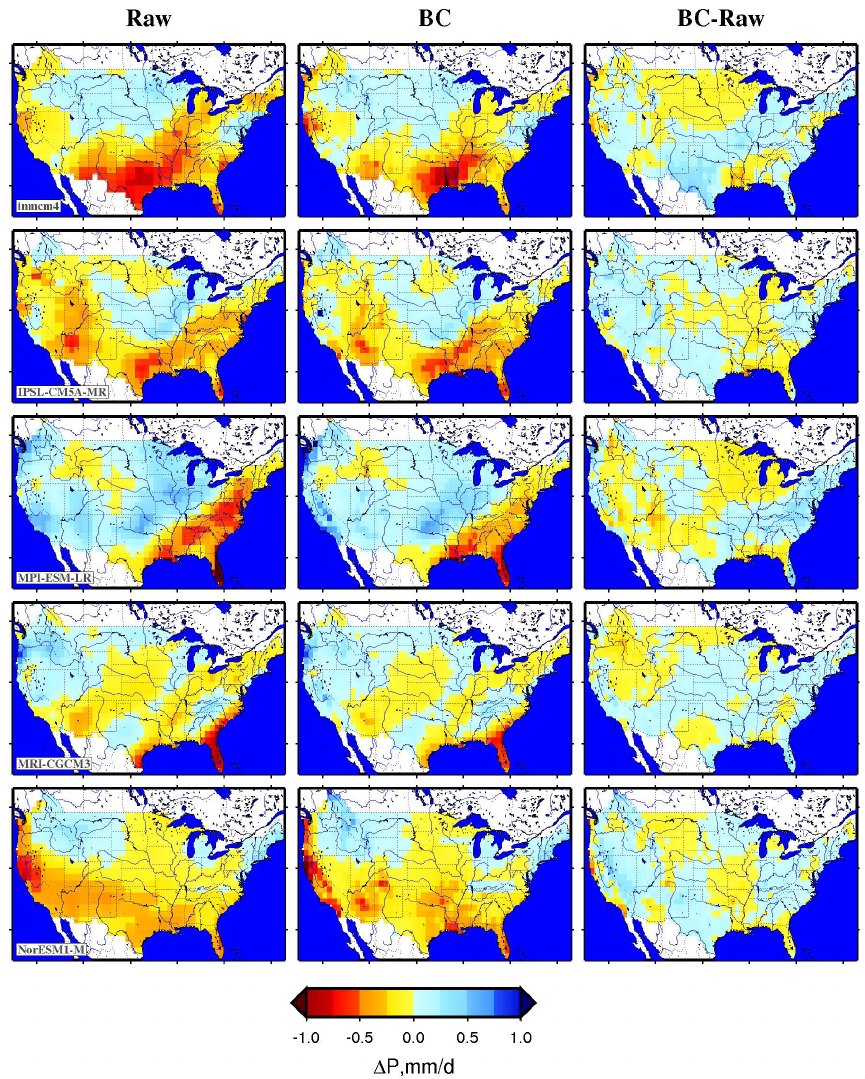
Fig. 5. Same as Fig. 4 but for GCMs